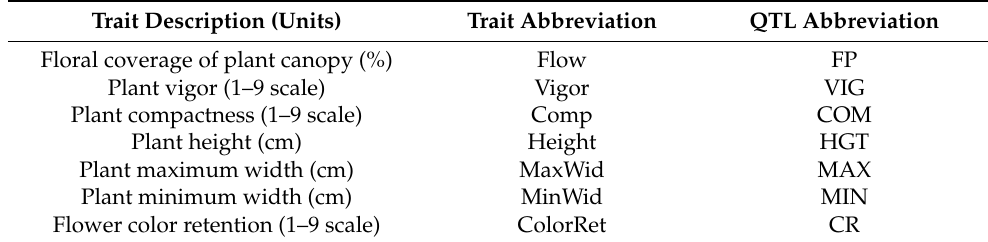
Table 1. List of traits measured and trait abbreviations. Trait Description (Units) Trait